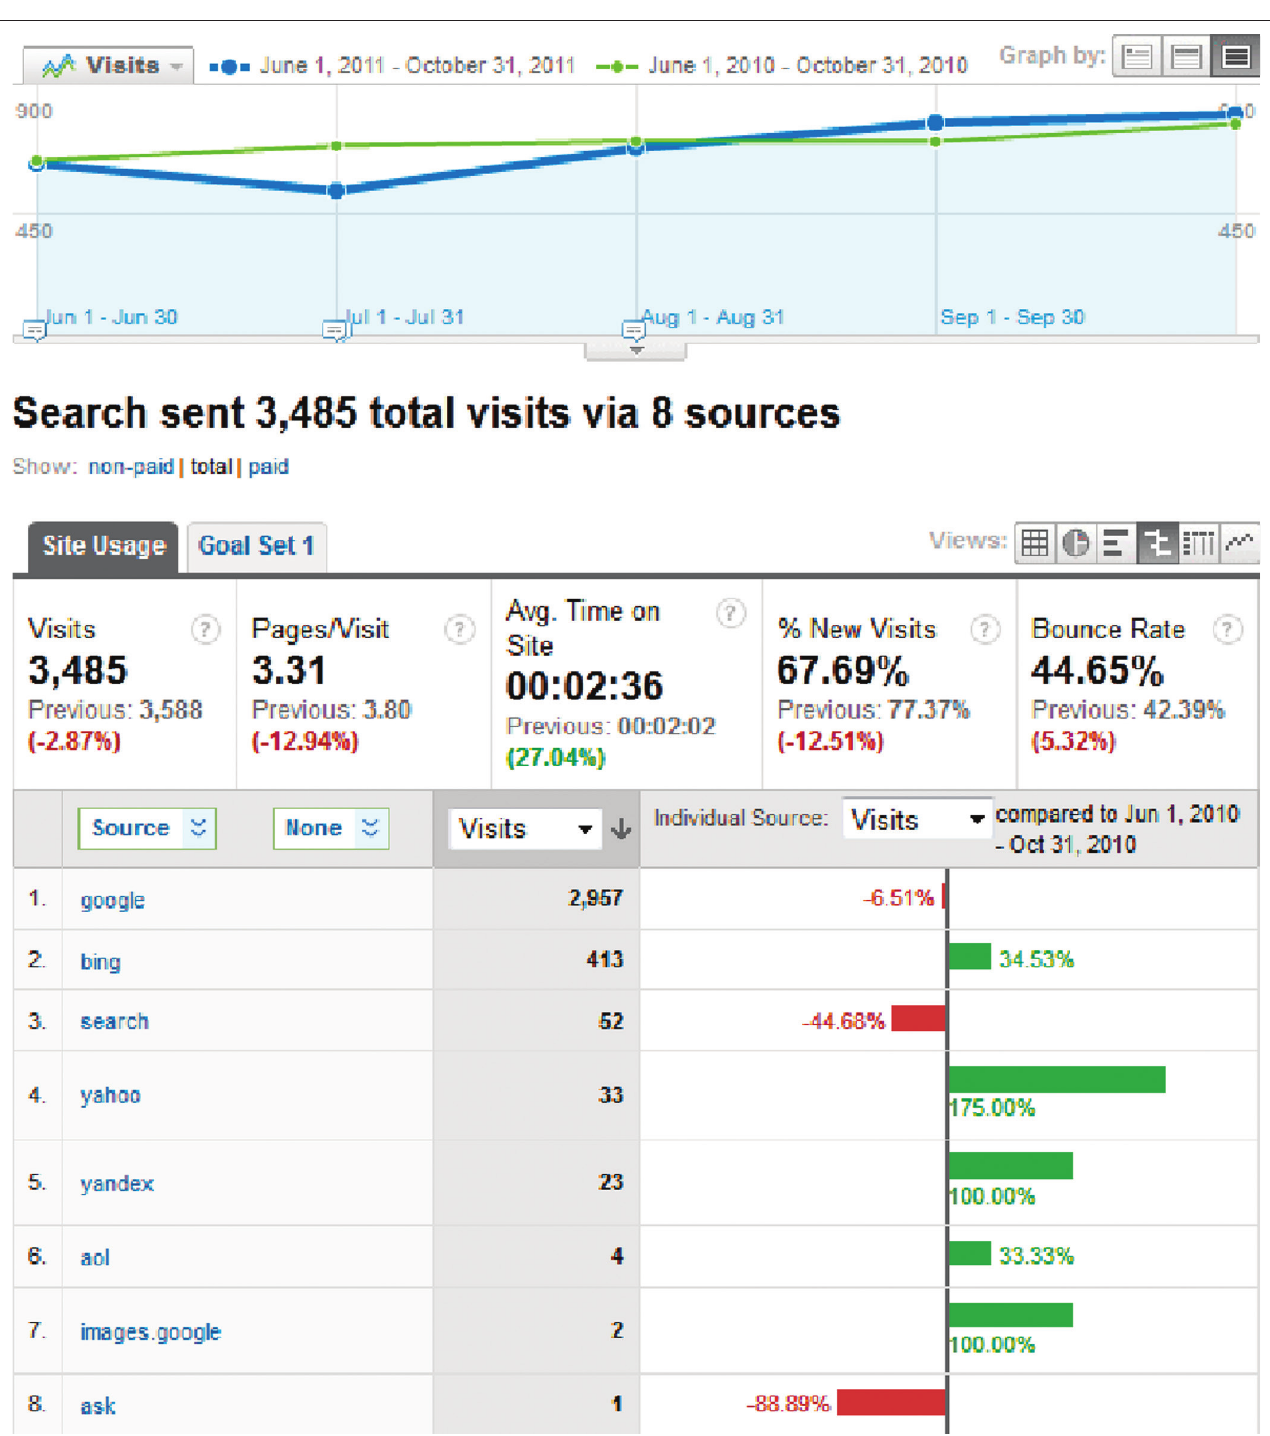
Figure 7. At a fixed rate of R3000 per month, XYZ had